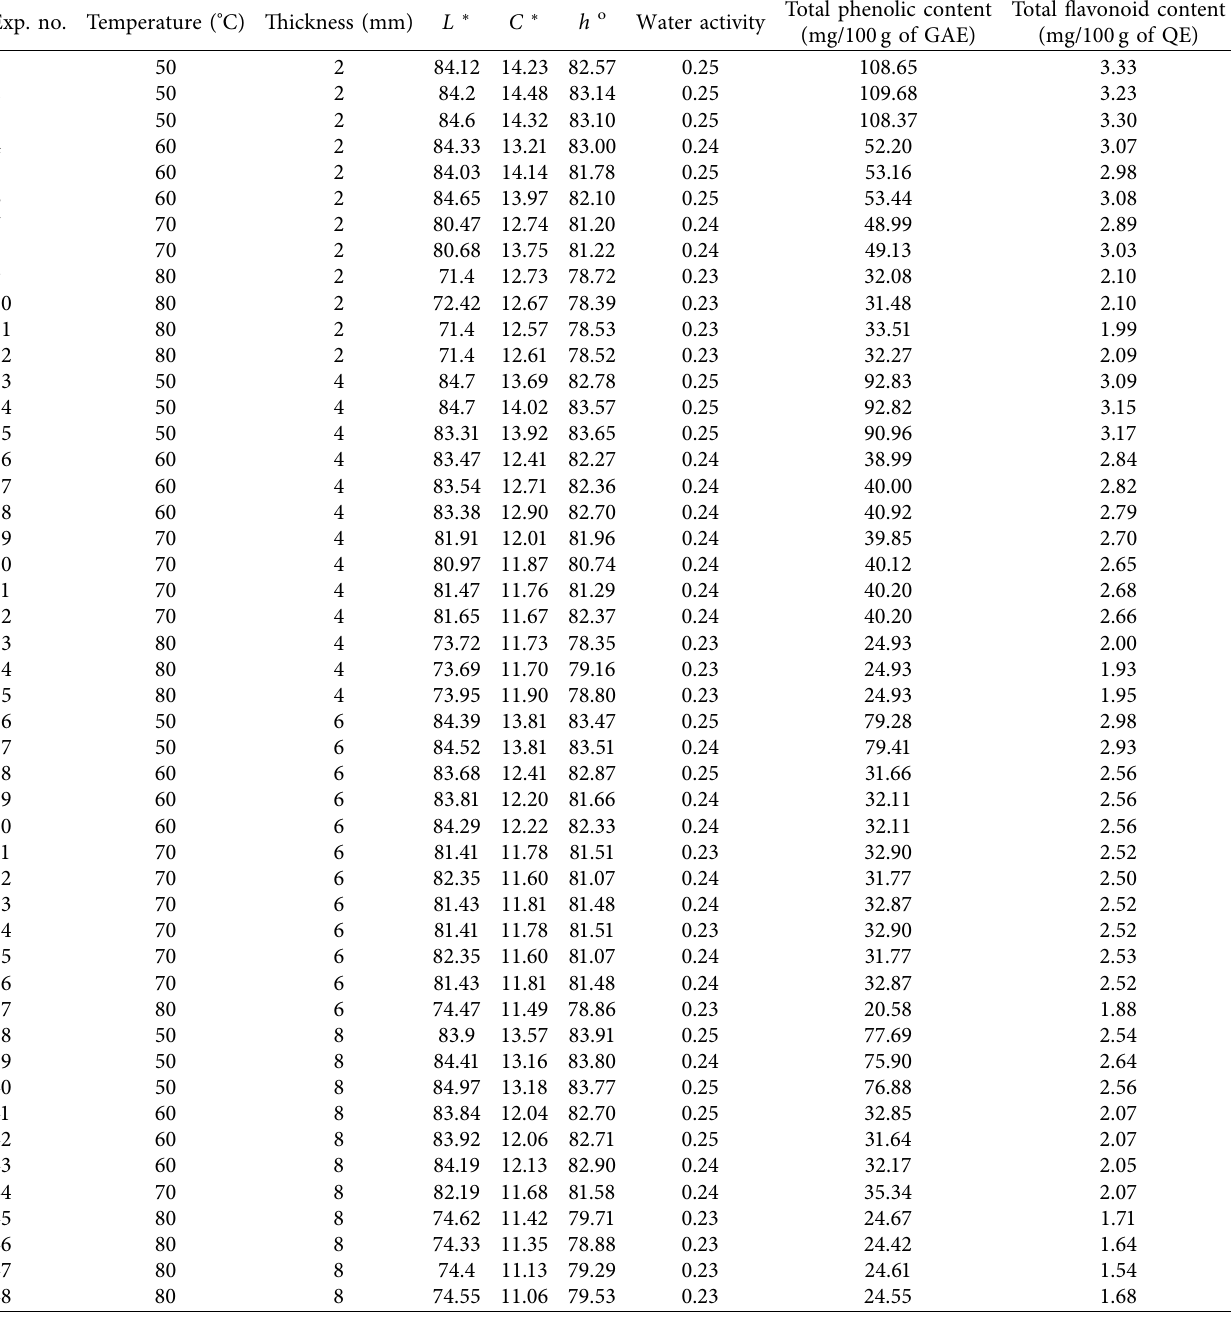
Table 2: Experimental design for the tray-dried green banana slices and the response